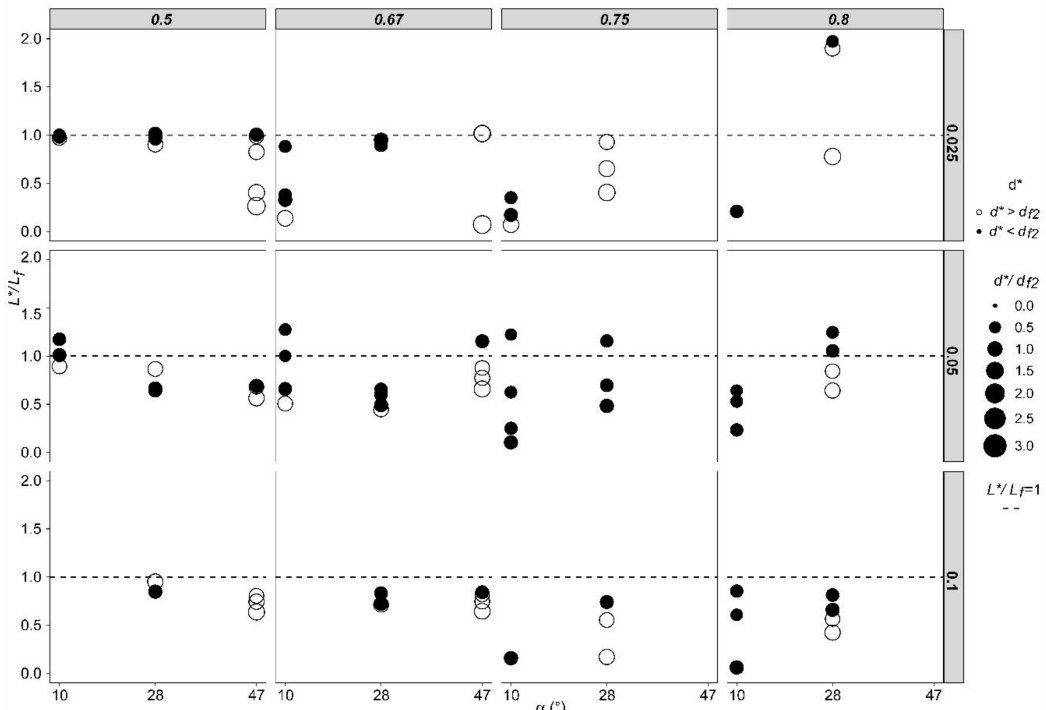
Figure 9. The L* / L f ( − ) rate with respect to α ( ◦ ) for tests with a P of zero. The figure is organized in a matrix layout, with vertical columns representing K Q ( − ) and horizontal rows Q T (m 3 s − 1 ). Filled circle represent cases where d* < d f2 ; empty circles represent d* > d f2 . The size of every circle represents the d* / d f2 ( − )